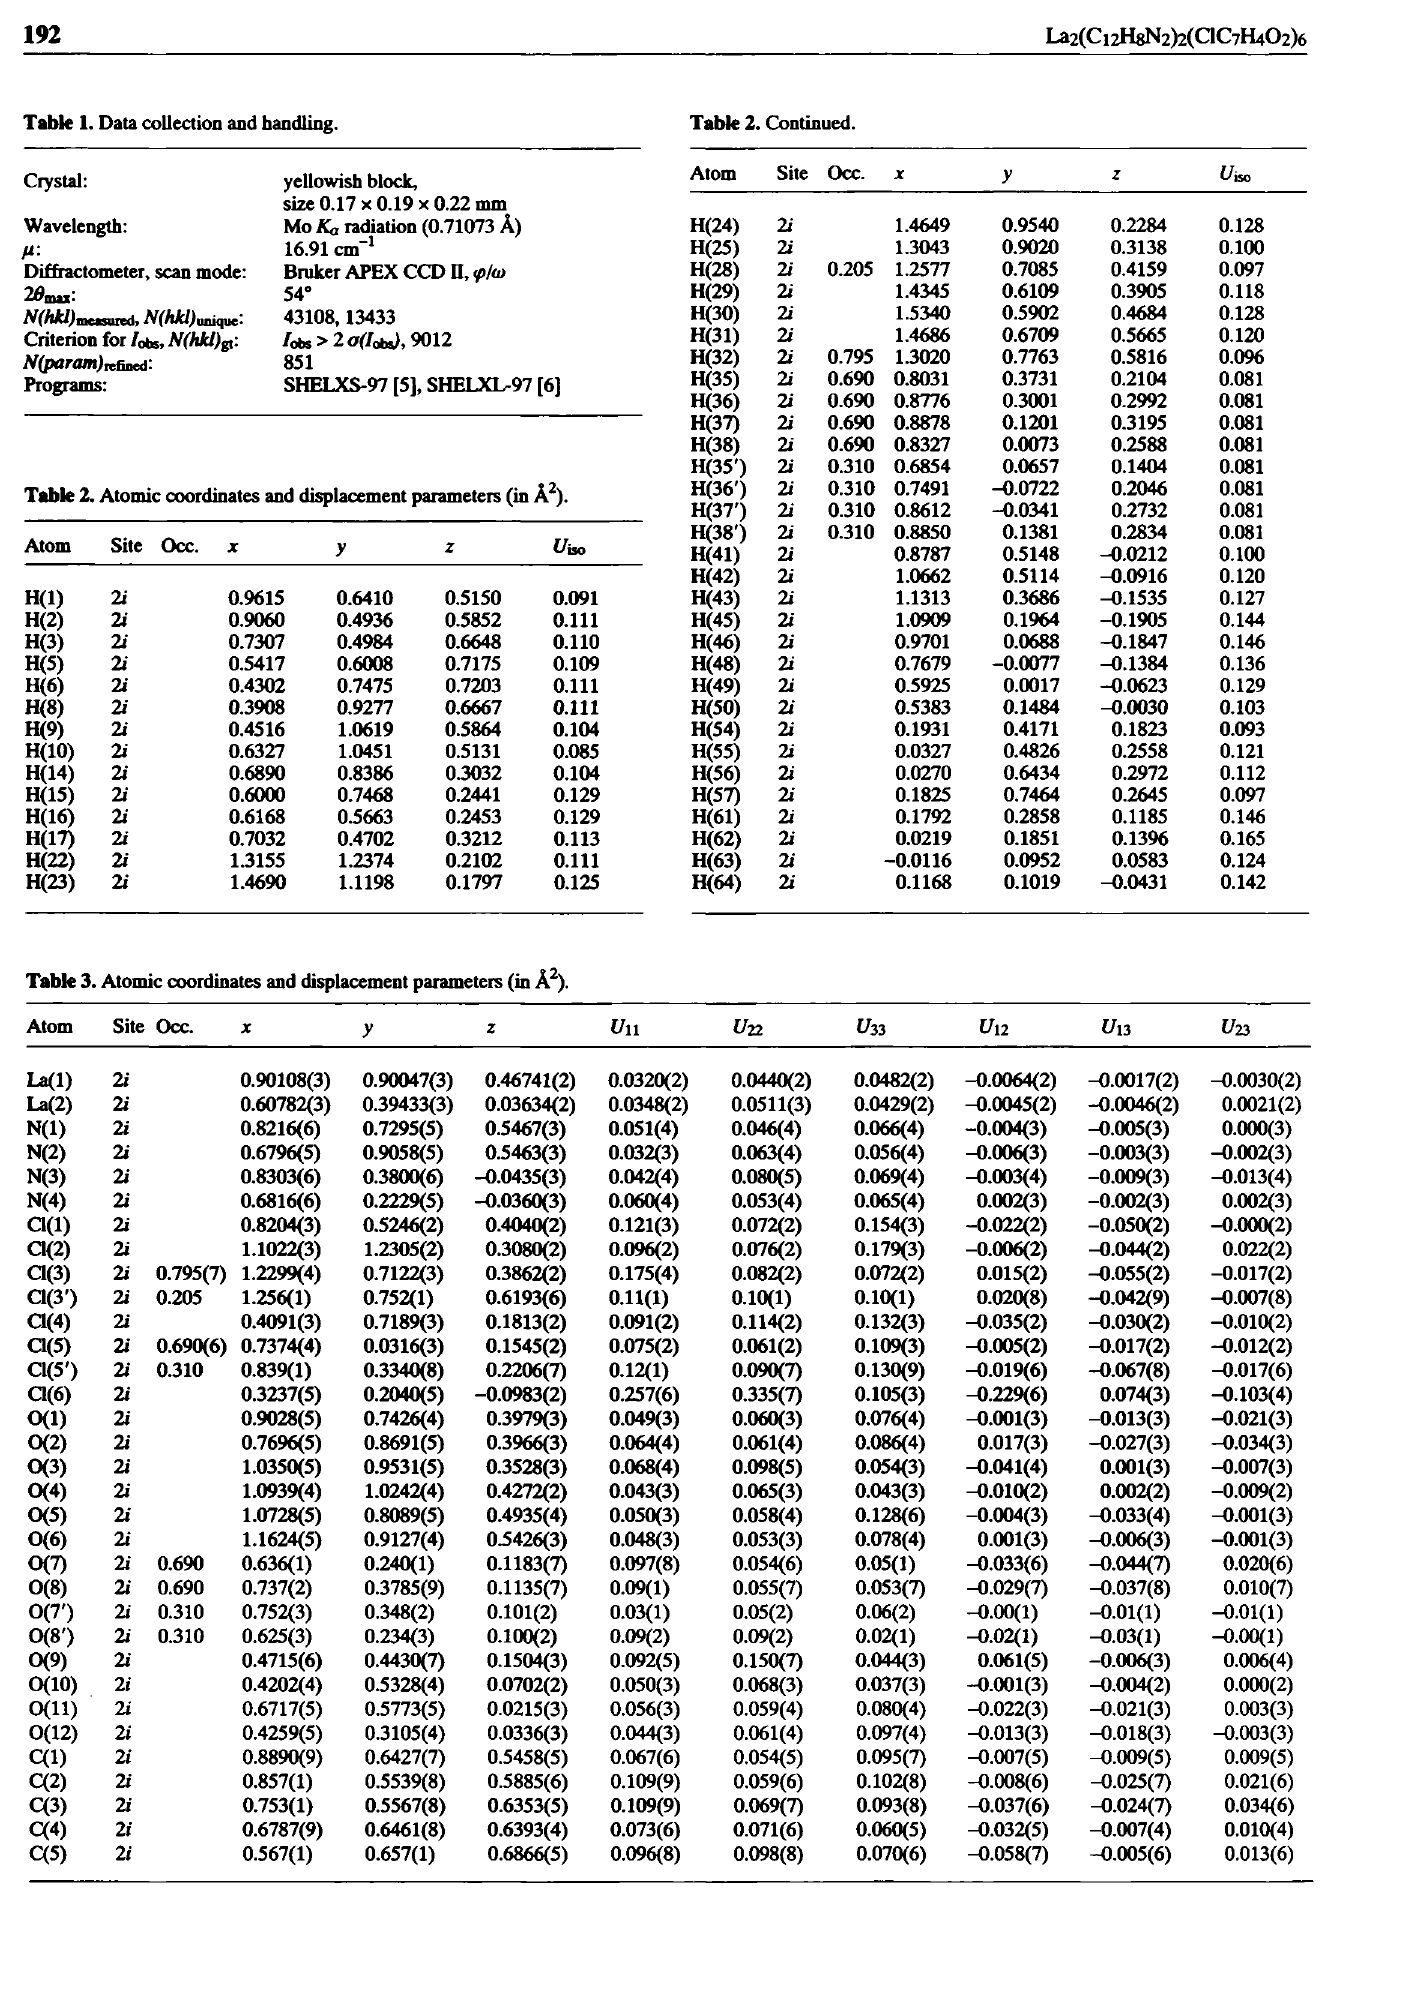
Table 2. Atomic coordinates and displacement parameters (in A 2 ).